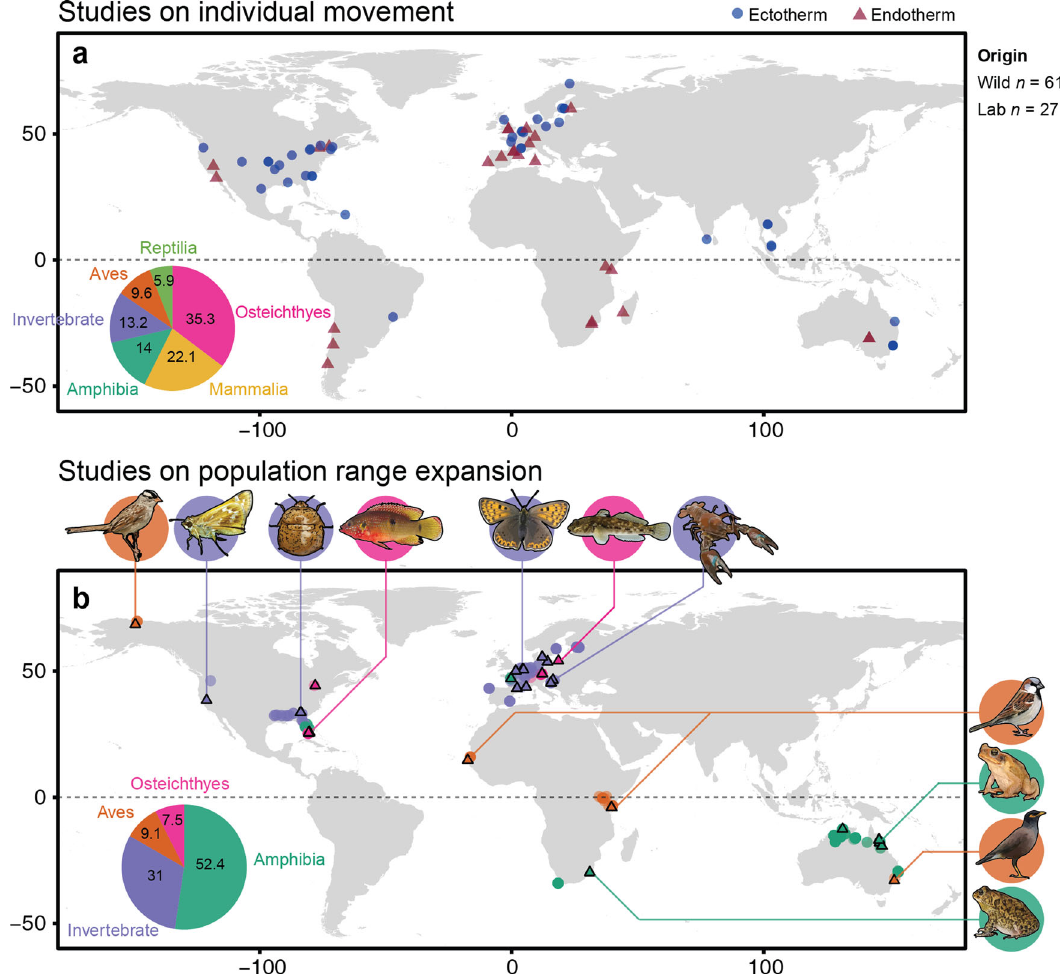
Fig. 1 Geographical distribution where extracted studies were conducted. a Locations of studies that investigated the relationship between physiology and dispersal propensity using wild animals, or where wild animals were collected for laboratory-based study. Data were coloured by thermal strategy (ectotherm as blue circle, and endotherm as red triangle). b Location of studies that compared physiology and locomotion between populations from the range core (triangles with black outline) and range edge (open circles). Data were coloured by taxonomic groups as shown in the inset pie chart (%). Example species listed from left to right, and top to bottom: Zonotrichia leucophrys , Atalopedes campestris , Megacopta cribraria , Hemichromis letourneuxi